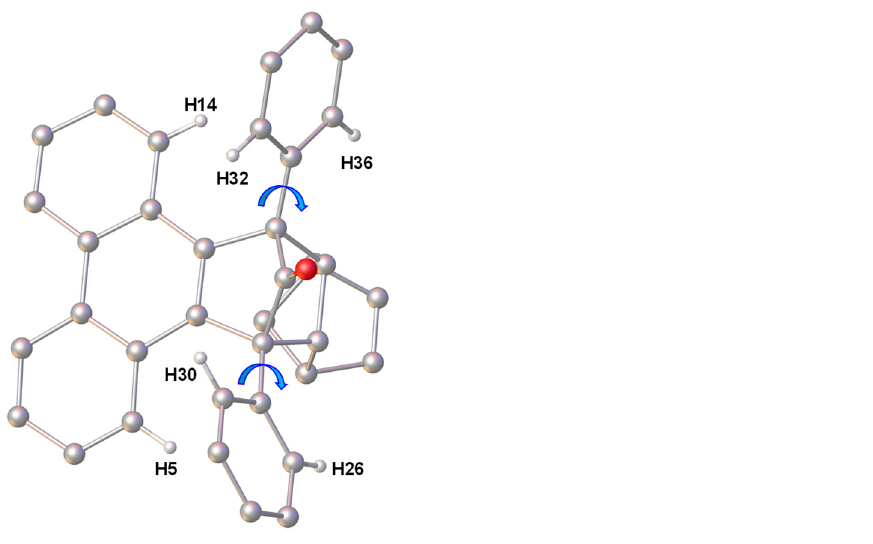
Figure 2. Illustration of phenanthrene and phenyl hydrogen atoms associated with steric interactions that result in restricted rotation of bridgehead phenyl groups.